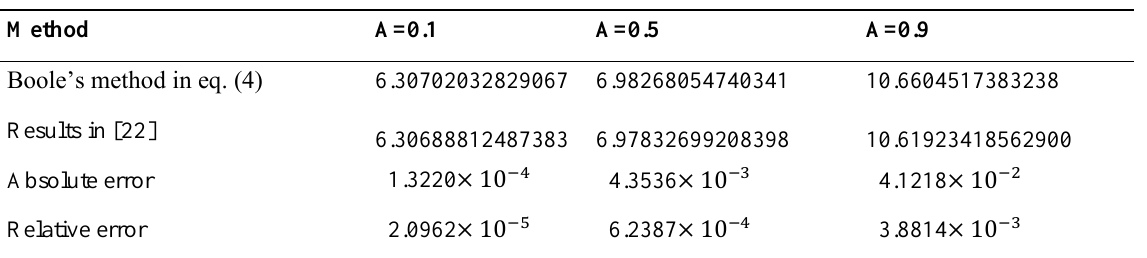
Table 2. Numerical results in (4) compared with the exact solution in paper [22], in different values of A, where n=60.